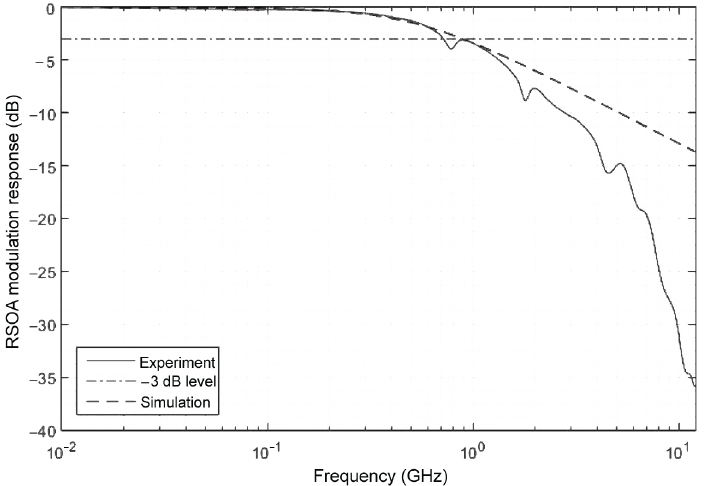
Figure 3. RSOA modulation response curves: theoretical (dashed line) and experimental (solid line). The horizontal dashed-dotted line denotes the 3 dB modulation